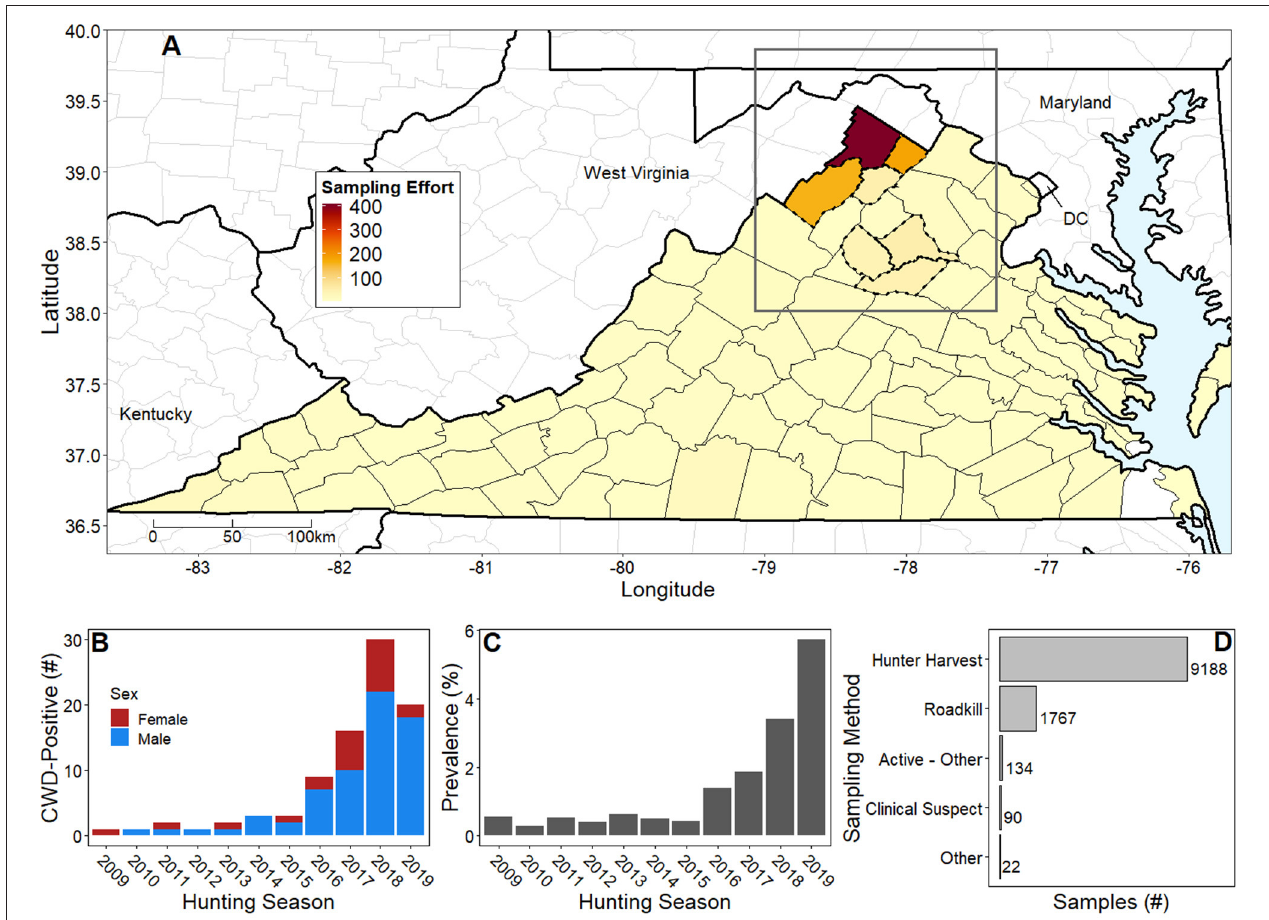
FIGURE 1 | Natural history of chronic wasting disease in Virginia, US from 2007 to early 2020. (A) Virginia county colors represent average annual number of deer samples ranging from no samples (white) to highest sampling intensity in Frederick County (dark red; ∼ 400 deer/year); mean cumulative number of samples is 143 white-tailed deer per county. In response to CWD detections, DWR increased sampling intensity and delineated disease management areas (dotted county lines). Our case study area (dark gray rectangle) focused on the northern tip of Virginia and portions of Maryland, Pennsylvania, and West Virginia. (B) Stacked bar chart shows sex ratios of CWD-positive cases from 2009 to 2019 hunting seasons. The apparent drop in the number of cases in 2019 is attributed to reallocation of DWR resources to prioritize sampling in non-CWD endemic counties. (C) Bar chart shows prevalence in CWD endemic Frederick County from DMA1 increasing over time. Details of higher prevalence values in some regions are lost due to administrative boundaries. (D) Horizontal bar chart shows hunter harvest as the predominant sampling method, followed by testing roadkill and clinical suspect cases. Please note that hunting seasons begin in late calendar months (typically November) and extend into early months of the following